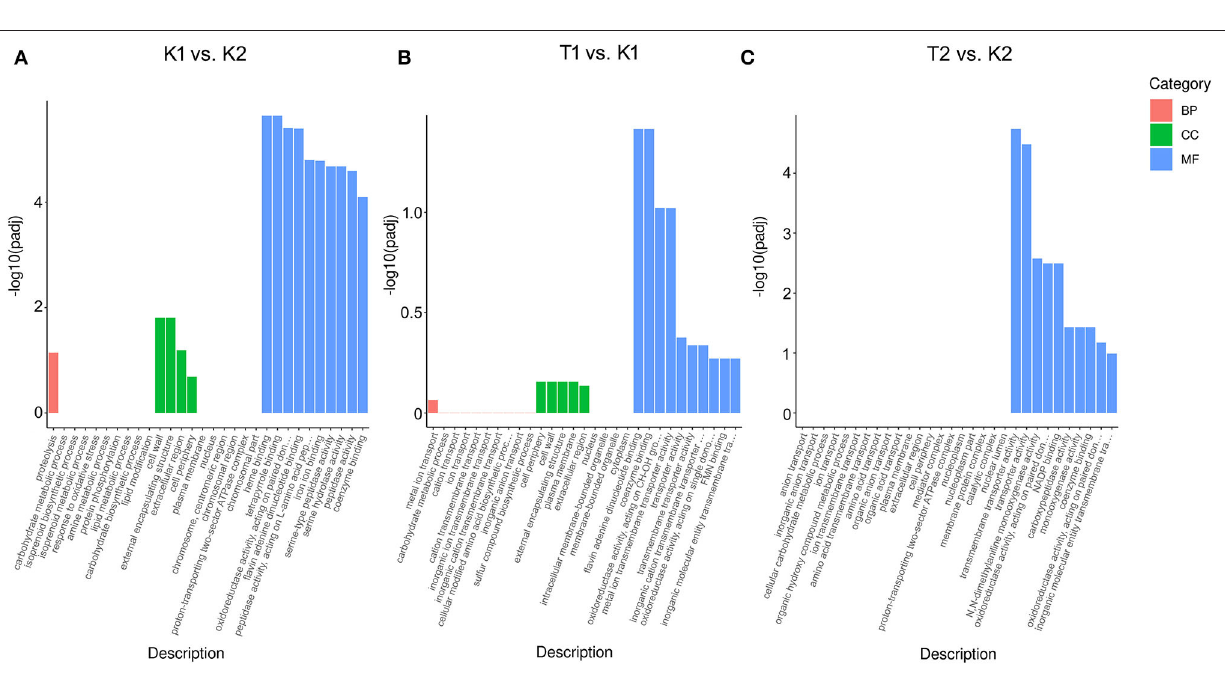
from multiple regions of the genome were filtered out).